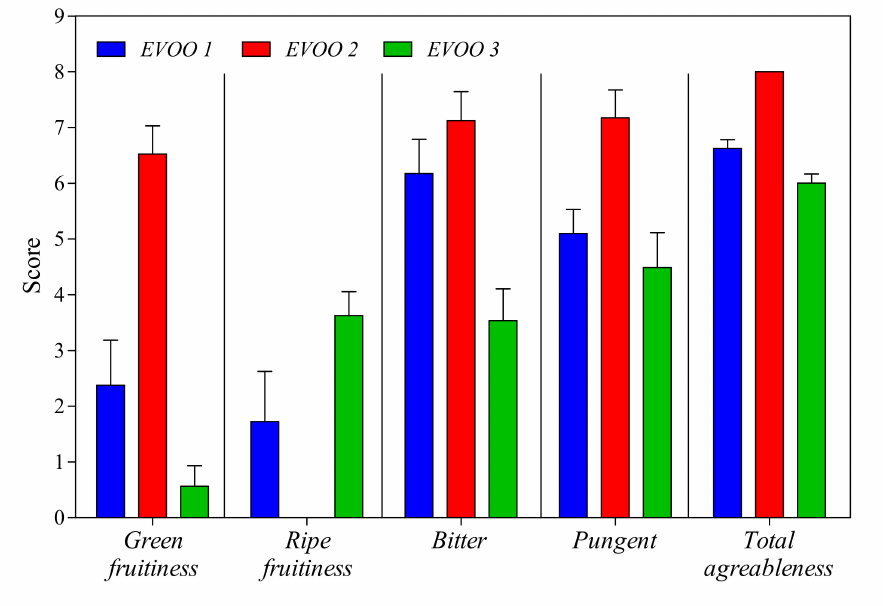
Figure 2. Bar plot of quantitative descriptive attributes of the three extra-virgin olive oils (EVOOs) studied.